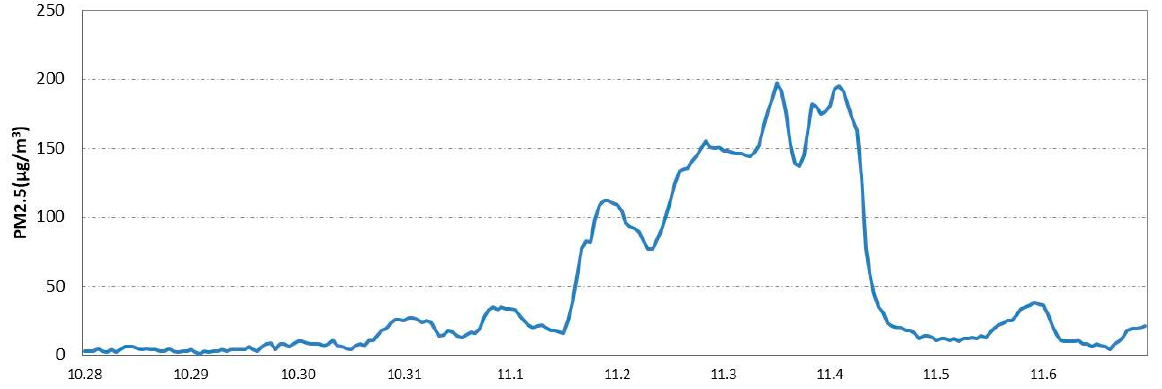
Figure 4. The ground-based PM2.5 concentration measurement over Beijing from 28 October to 6